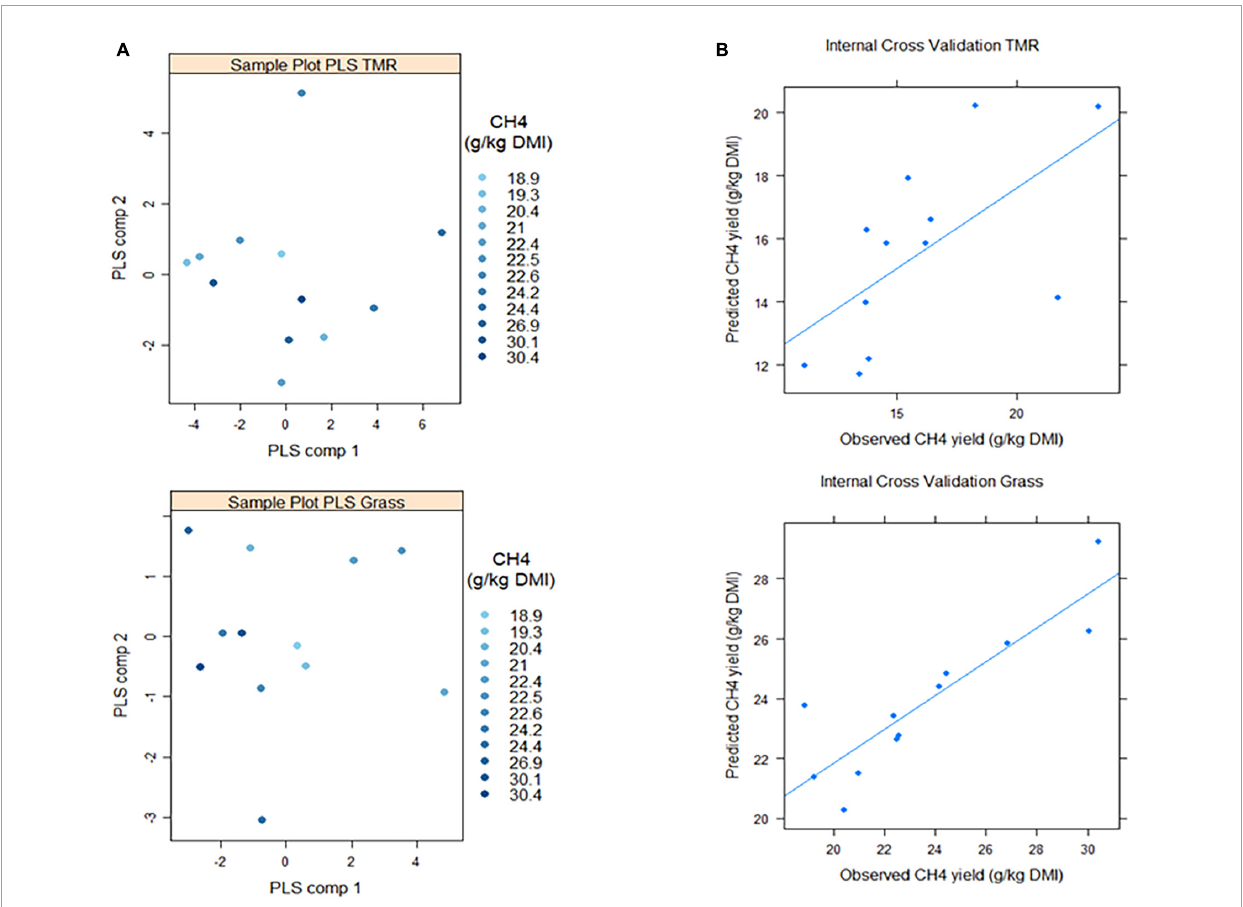
FIGURE3 Results from linear projection of latent structures regression (PLS) models aiming to predict methane yield (g/kg DMI) based on 28 or 25 clr -transformed microbial genera in fresh cut grass (Grass) or high concentrate (TMR) fed animals. Full details of the PLS models can be found in Supplementary Table 2 . (A) Sample plots (both PLS models were built with one single component, but two components were fitted only for visualization purposes). (B) After a threefold cross-validation procedure repeated 20 times, methane yield was predicted with 85 ± 8% (Grass) and 66.5 ± 9% prediction